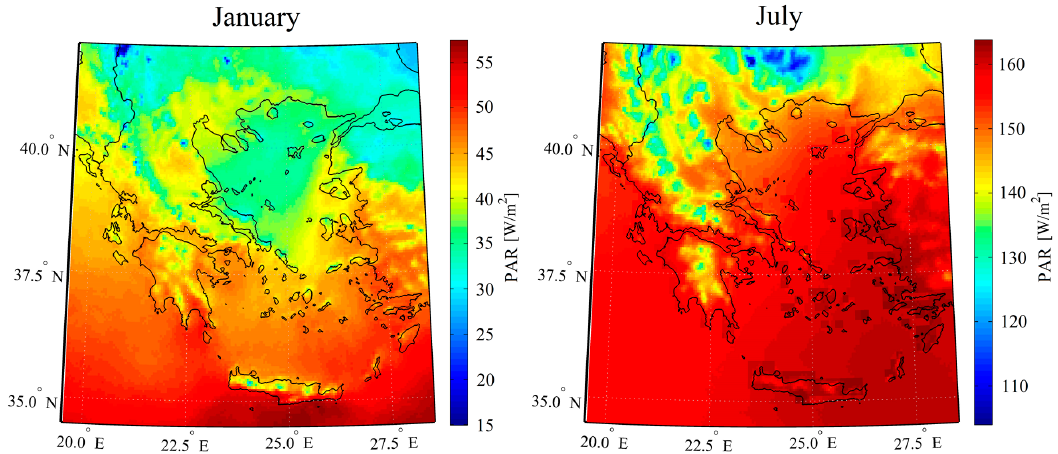
Figure 2. The mean daily Photosynthetically Active Radiation (PAR) for January and July.